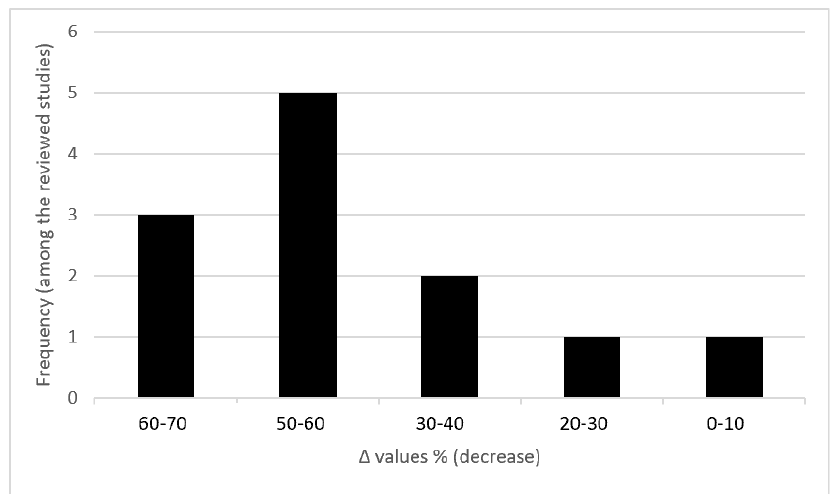
Figure 3. Percentage decrease in cardiac tissue GSH (% Δ values : [(values of rats exposed to anthracyclines) − (values of control rats)] × 100) in rats exposed to anthracyclines compared to control animals as they are reported in 12 relevant studies reviewed by Georgiadis et al. (2020) [17] (data from Georgiadis PhD thesis not currently published). %Δ values were calculated in order to overcome the diversity of measuring units used in the literature.